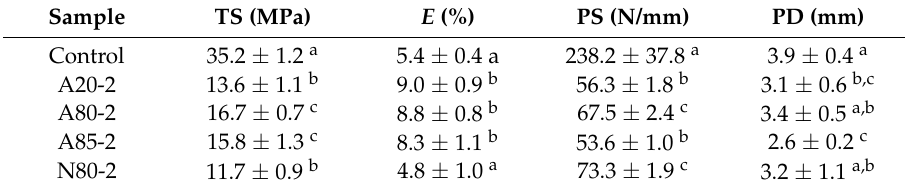
Table 7. Mechanical properties of chitosan films (TS: tensile strength, E : elongation at break, PS: puncture strength, PD: puncture